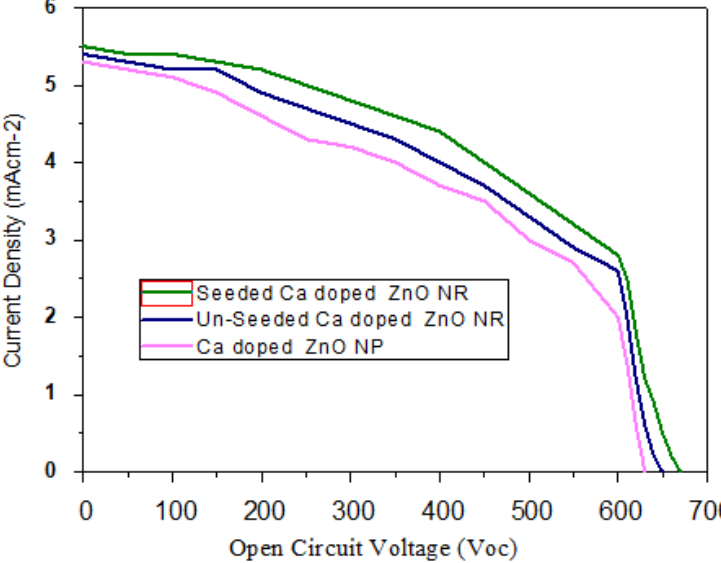
Figure 11. Photovoltaic characteristic plot of Ca-doped ZnO nanoparticles, unseeded nanorods, and seeded nanorods .